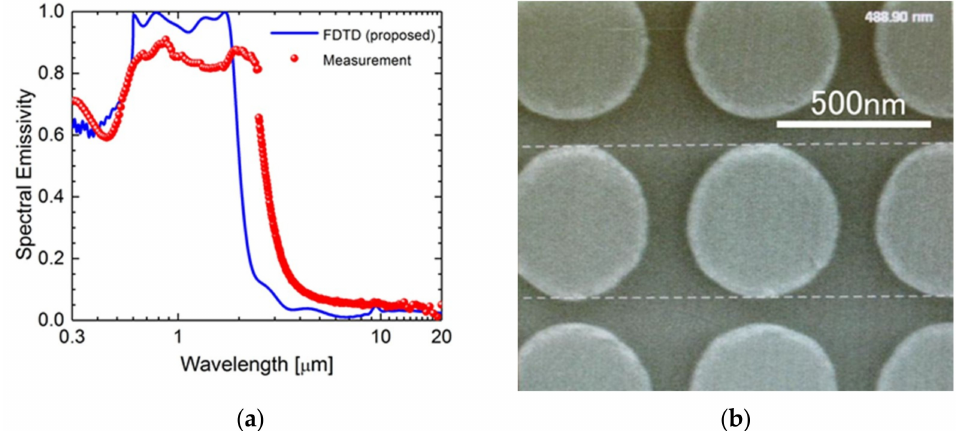
Figure 3. ( a ) Spectral emissivity of the proposed emitter obtained from FDTD simulation (blue line) and the fabricated sample (red dot). ( b ) Scanning electron microscopy (SEM) images of the fabricated metasurface from the top.